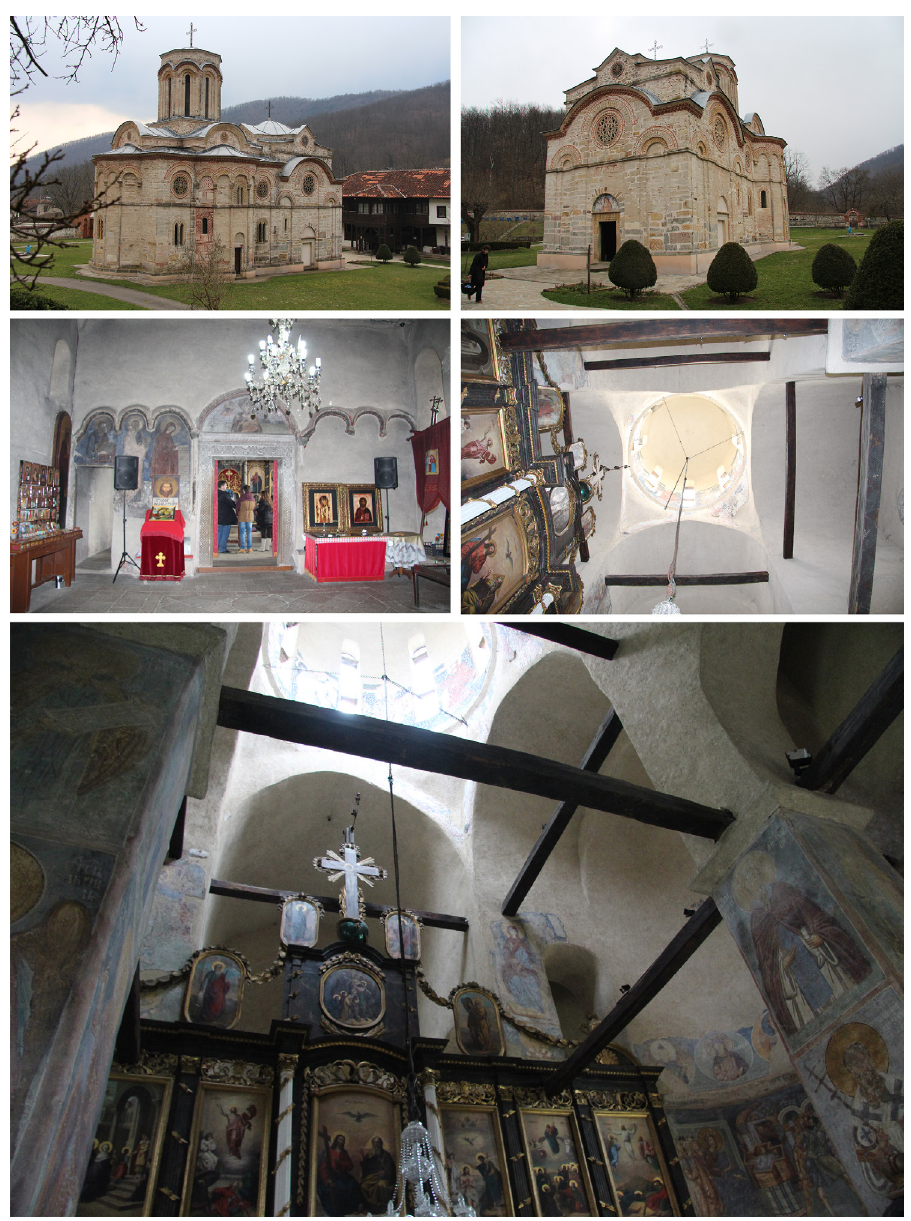
Figure 1. Temple of the Uprising of the Holy Mother of God, Ljubostinja monastery: exterior view (top), view from the narthex towards naos (middle left), central dome (middle right) and view towards the altar and wooden iconostasis. Photo credits: Zorana